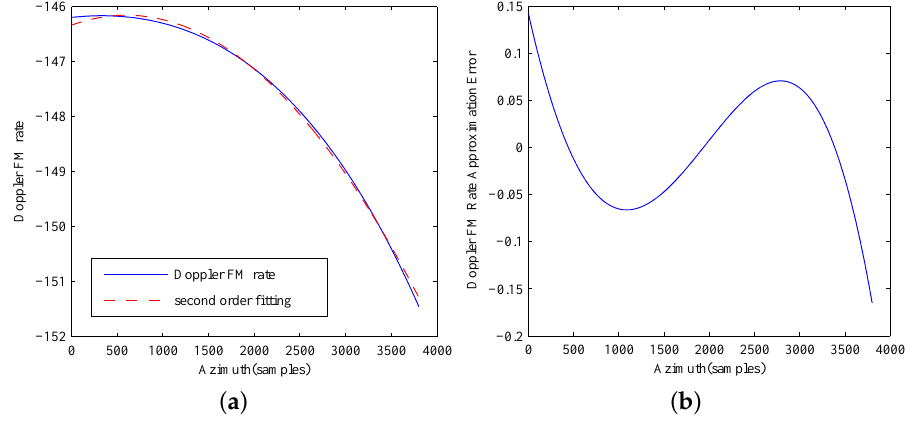
Figure 10. Diagram of the second-order fitting of the Doppler FM rate and its approximation error. ( a ) Doppler FM rate and its fitting curve; ( b ) Doppler FM rate approximation